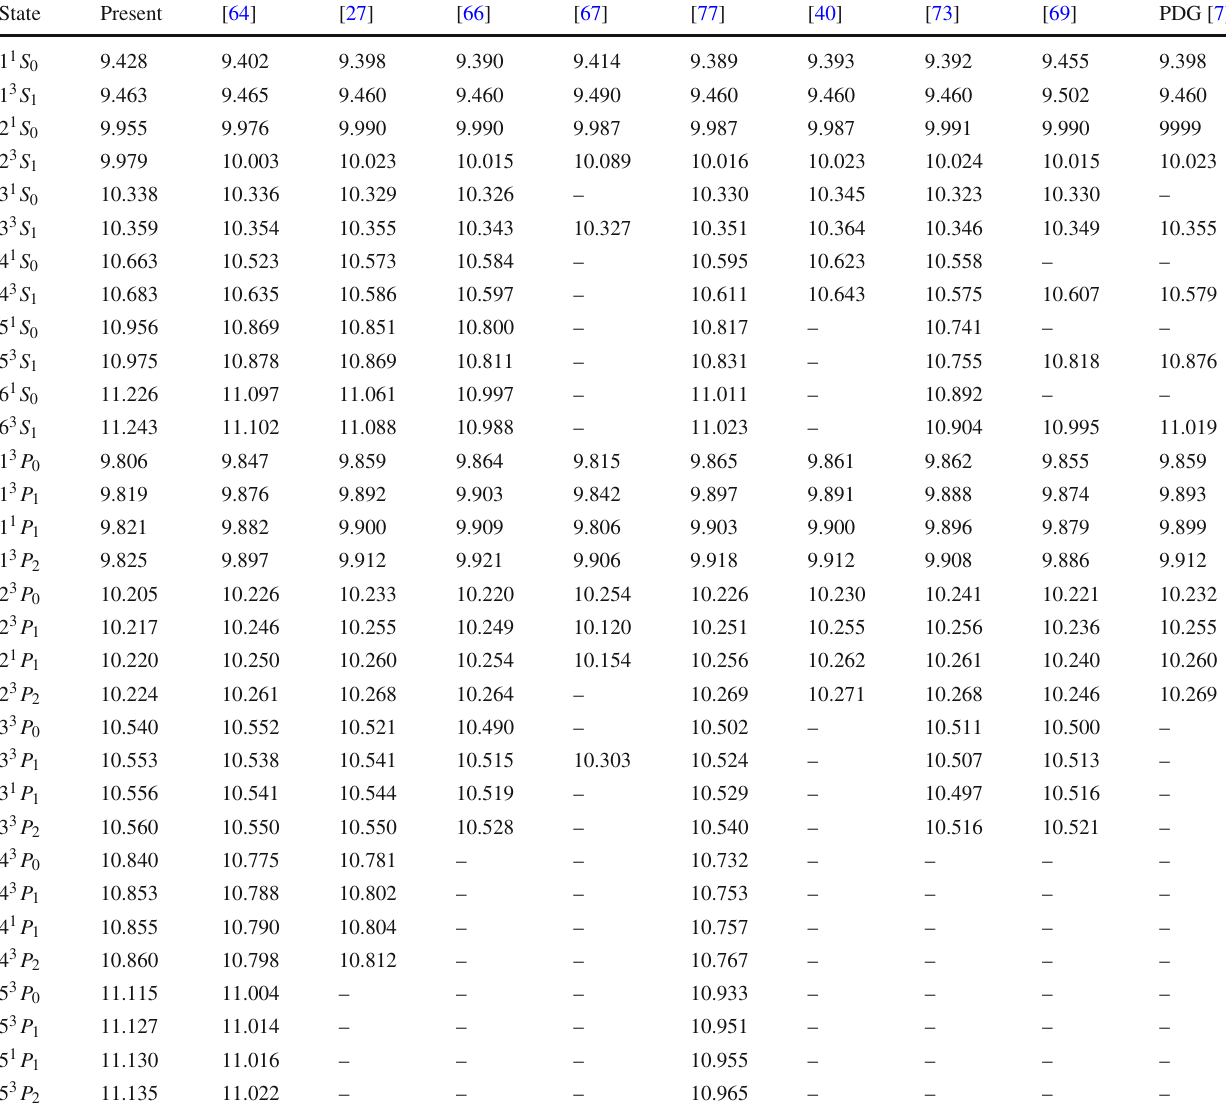
Table 4 Mass spectrum of S and P -wave bottomonia (in GeV)